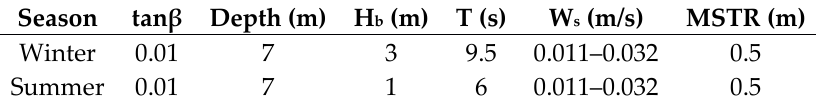
Table 1 . Reference data for characterization of the MR